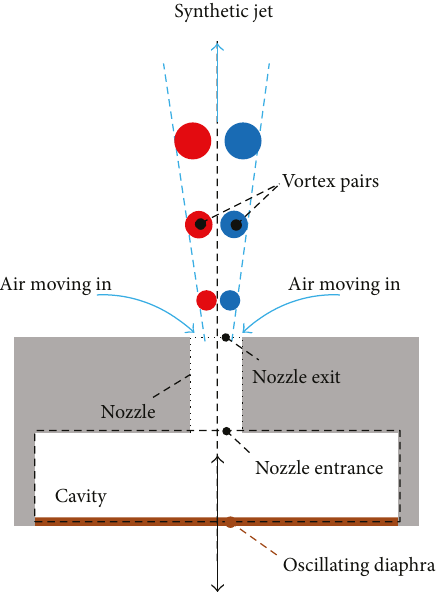
Figure 1: Schematic diagram of a synthetic jet